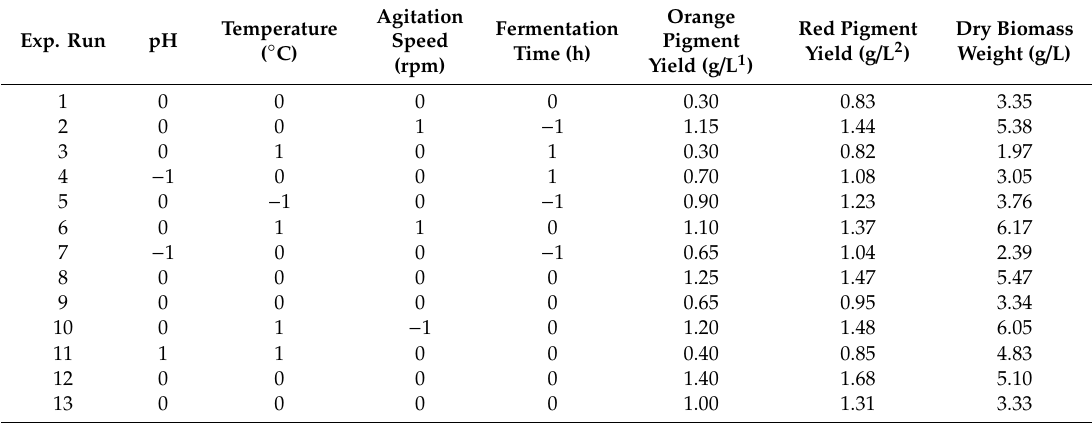
Table 2. Box–Behnken design matrix with the experimental responses over process parameters in Talaromyces albobiverticillius